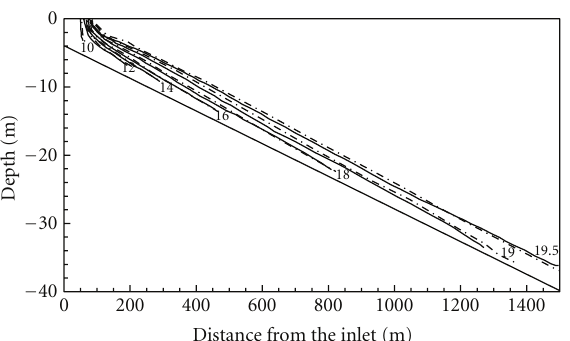
Figure 6: Comparison of simulated iso-contours (dashed lines) of temperature distribution and the results of Bournet et al. [29] (solid lines) at a quasiequilibrium state.